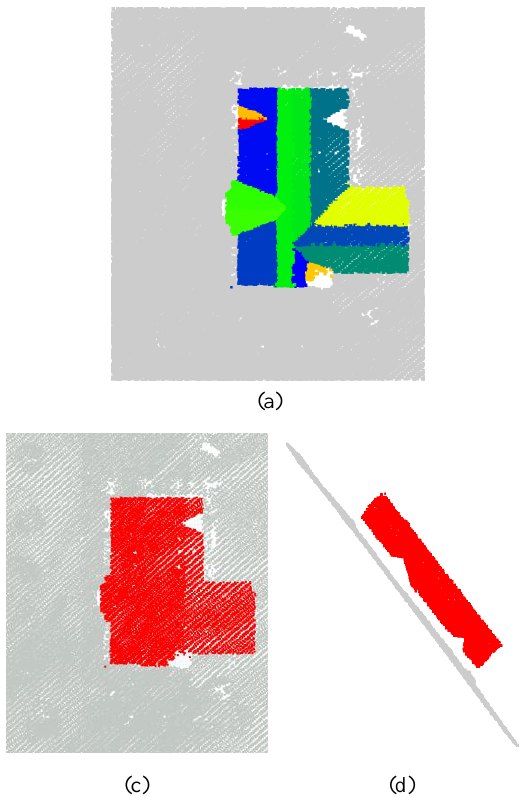
Figure 2. The result of the employed step-wise point cloud Figure 4. Classification result of regular surfaces, (a) is the segmentation, (a) is the original ALS point cloud data which is regular surfaces in a 3D local area, (b) is the top view of the colored by elevations, and (b) is the segmentation result which classification result, and (c) is the side view of the classification is colored by segments. result. The points coloured by red are building, and the points coloured by grey are